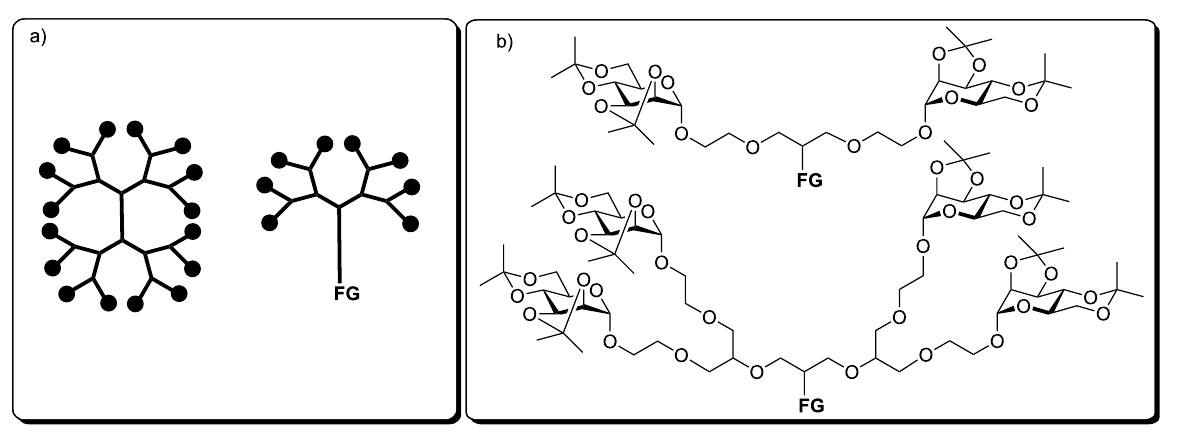
Figure 1: a) Dendrons (right) are branched fragments of dendrimers (left), featuring a functional group (FG) at their focal point which can be orthog- onal to all other functionalities of the molecule; b) di- and tetravalent polyether glycodendrons equipped with protected α -D-mannosyl residues were employed to test postsynthetic modification at the focal point; FG: double bond,